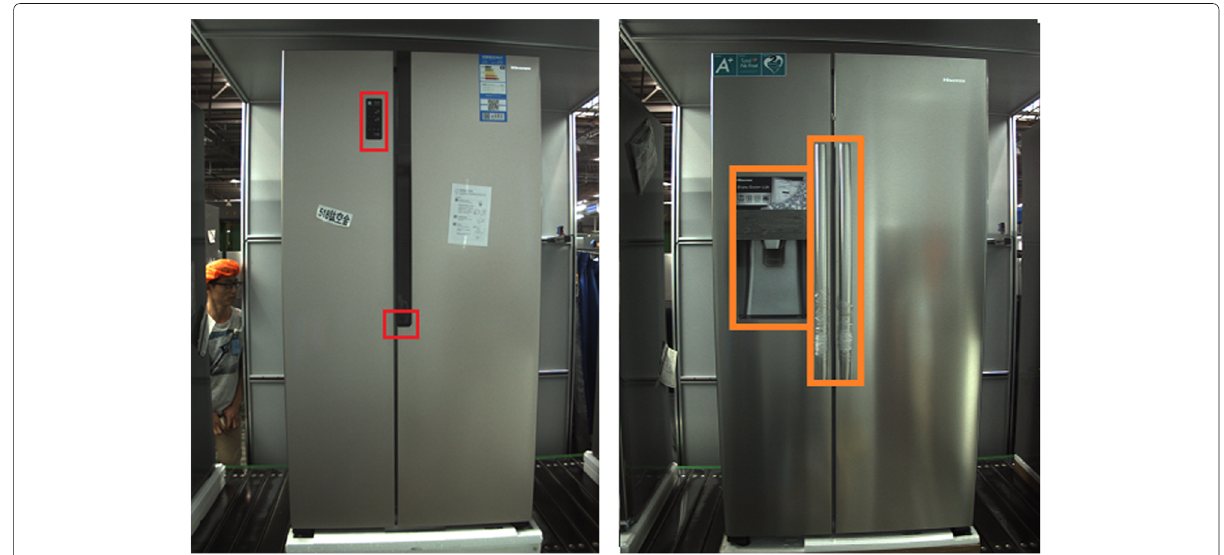
Fig. 3 The large homogenous areas and subtle salient regions in the front-view images of refrigerator